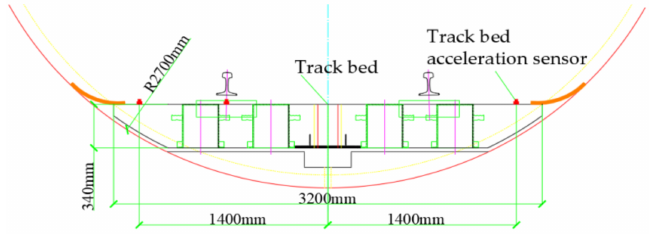
Figure 6. Layout of measuring points for the track-bed acceleration sensor.